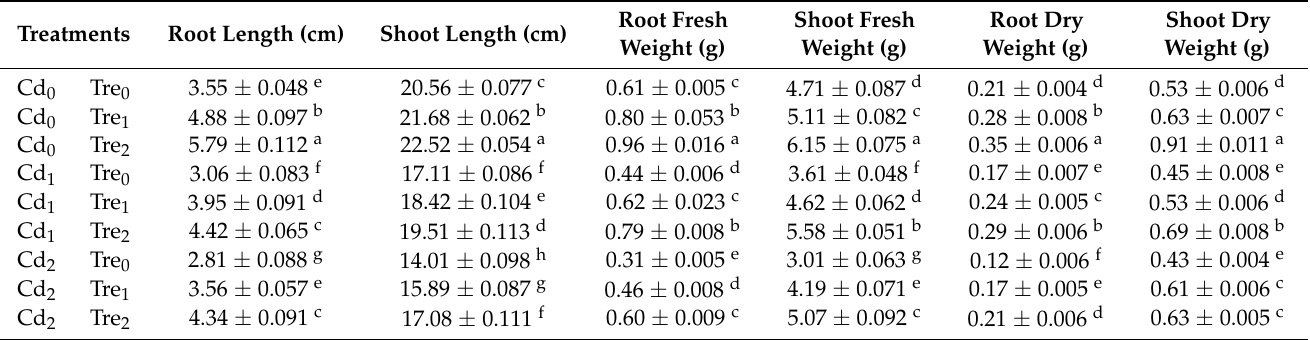
Table 2. Effect of Tre supply on the growth and biomass traits of mung bean grown in hydroponic culture under normal and Cd stress